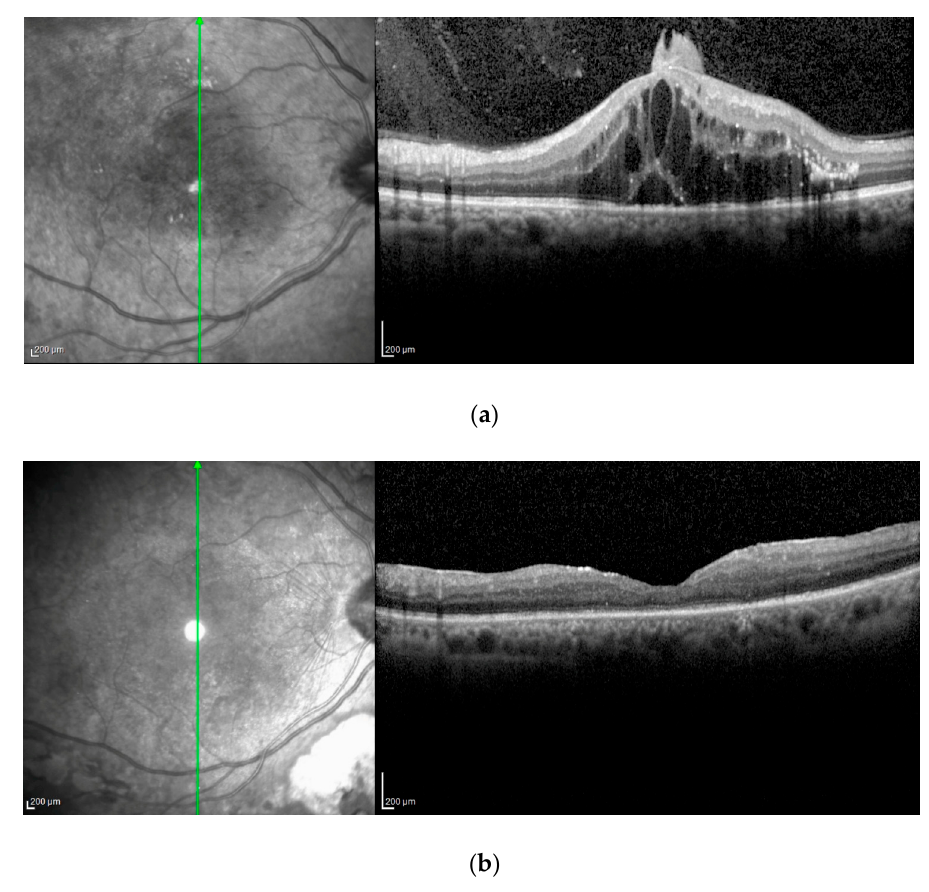
Figure 3. ( a ): Severe diabetic macular edema (DME) with subretinal fluid (SRF) and nodular epiretinal gliosis; ( b ): the same case two years after vitrectomy with complete resolution of DME.